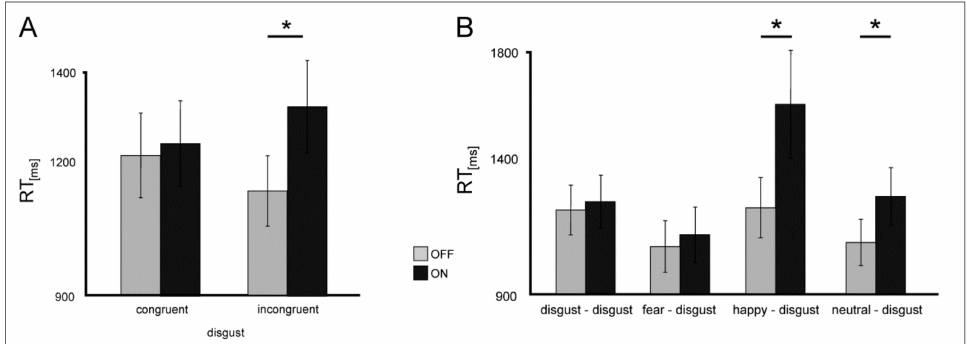
Figure 3. ( A ) Mean RT values (in ms) for congruent and incongruent disgust-connoted stimuli in the implicit task for Parkinson’s disease (PD) patients under deep brain stimulation (DBS) (light grey) and when DBS is switched OFF (dark grey). ( B ) Mean RT values for disgust-connoted prime-target pairs in the implicit task for patients under DBS (light grey) and when DBS is switched OFF (dark grey). Error bars show SE. Significant di ff erences are labeled with (*).